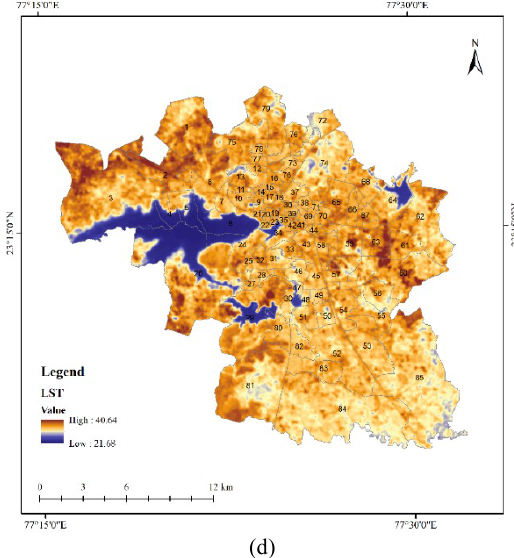
Figure 6. Images with spatial distribution of (a) NDVI (b) MNDWI (c) NDBI (d) LST